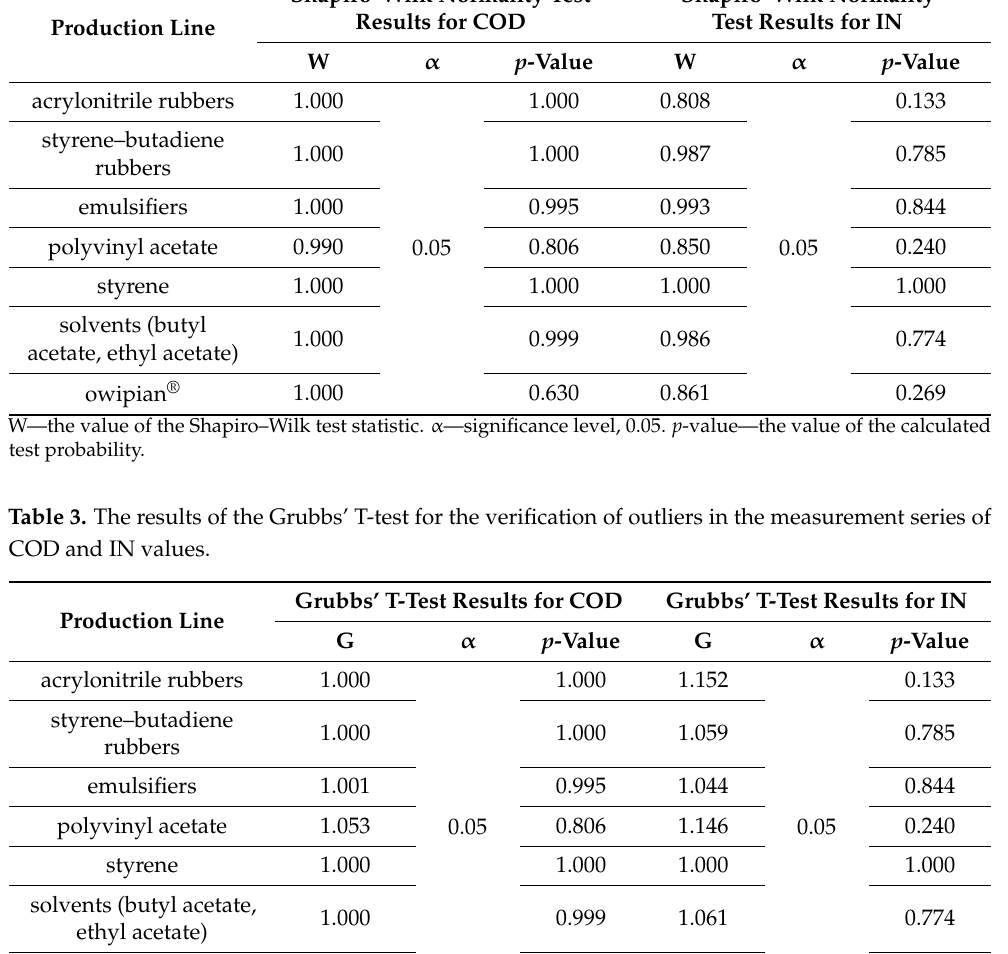
Table 2. The results of the assessment of the normality of the distribution of data including COD and IN values (Shapiro–Wilk test). Shapiro–Wilk Normality Test Shapiro–Wilk Normality Results for COD Test Results for IN Production Line W α p -Value W α p -Value acrylonitrile rubbers 1.000